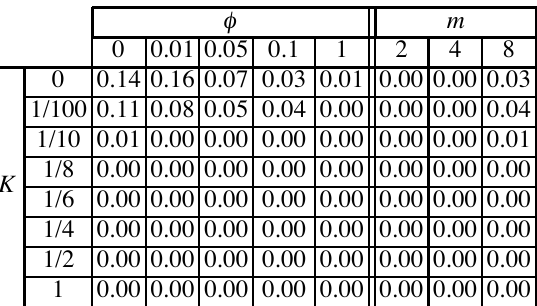
Table 5. Average M values for the SD